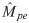
Data set M vs. v6M (or 10−2
D) and the model output M^pe for women patients’ population.